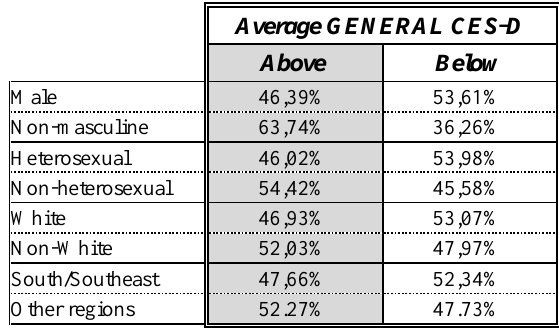
Table 4 : Proportional results by identity, population comparison Average GENERAL